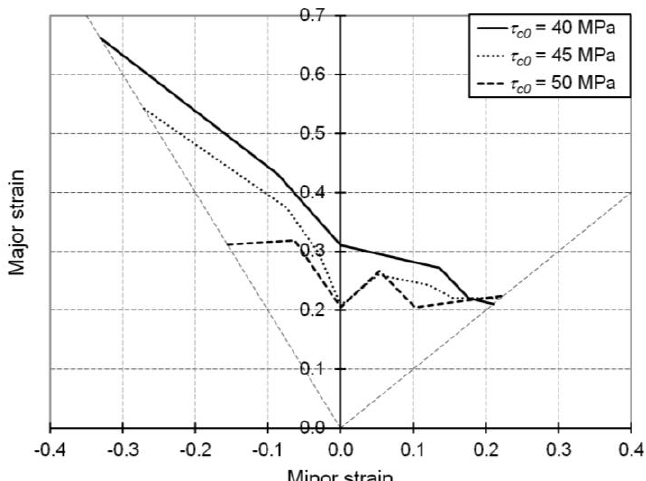
Figure 9. Simulated FLDs associated with linear loading paths for the IF – Ti single-phase steel as obtained with the Bifurcation–EPSC model: Effect of the initial critical resolved shear stress τ 0 c